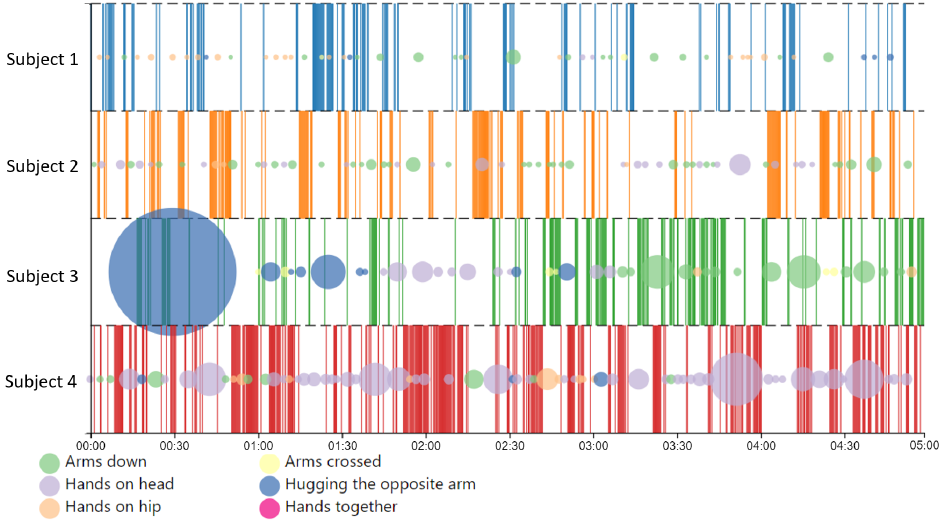
Figure 6. Timeline visualization for the Competitive